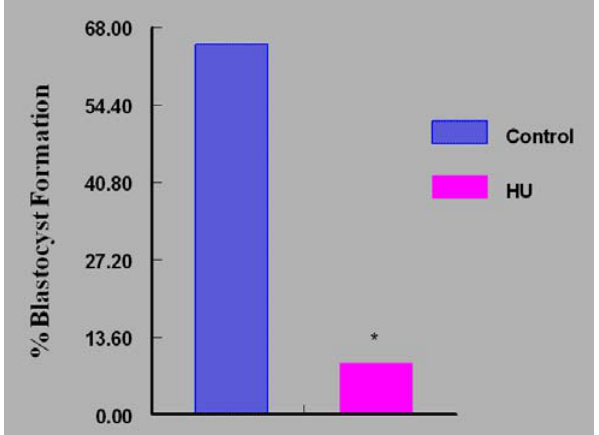
Figure 7. Effect of Continuous in vitro Exposure of Embryos to Bioavailable HU (18 µg/mL) on Their Ability to Develop to Blastocyst Stage; n = 50 per Group. Results are expressed in percentages (HU = treated embryos; Control = vehicle treated embryos. Asterisks indicate a significant difference from controls ( P <